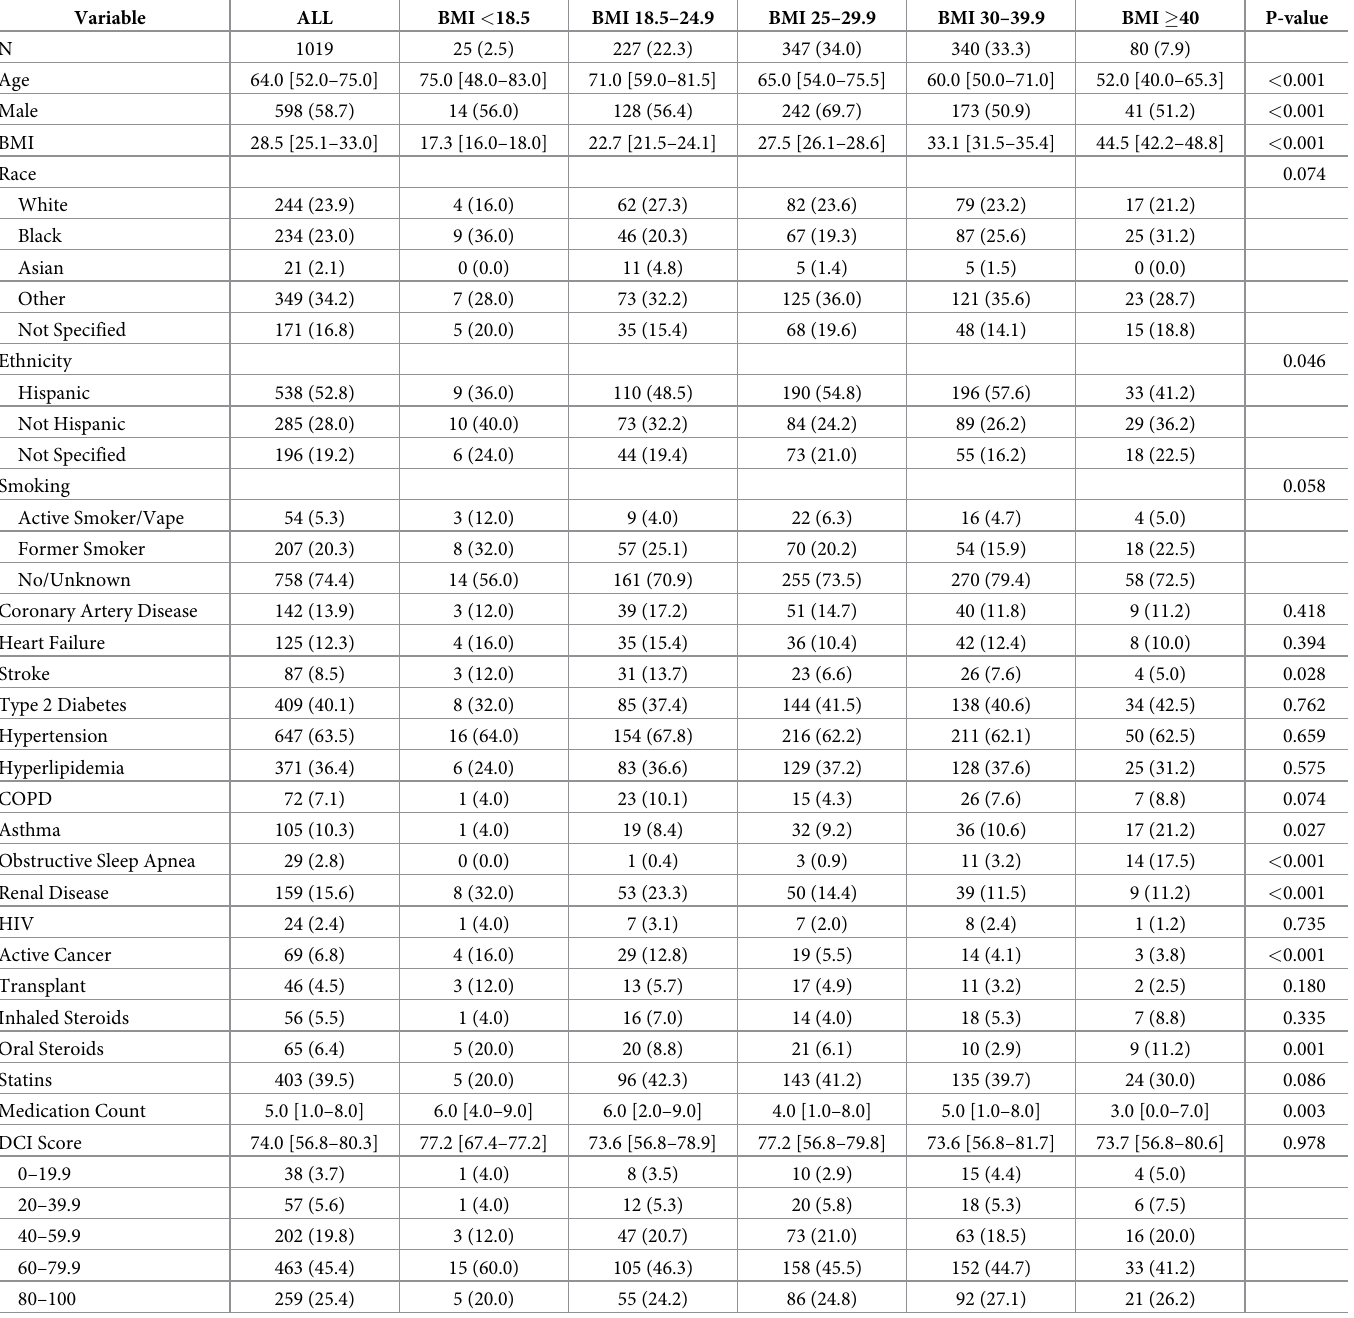
Table 1. Patient characteristics by BMI